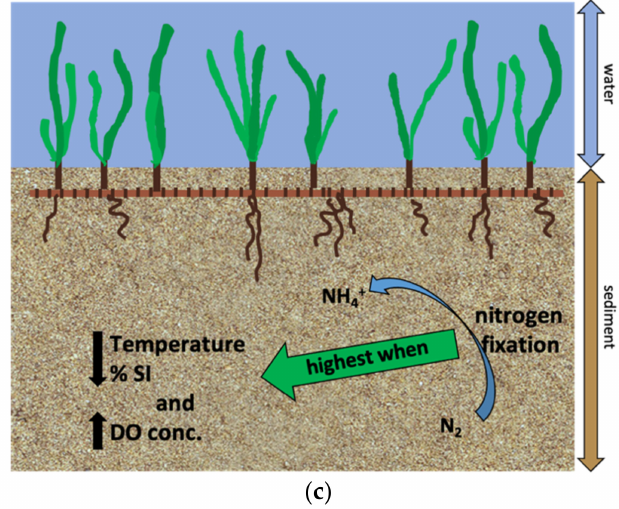
Figure 8. Conceptual models for conditions that stimulated sediment nitrogen fixation in the different substrate types: ( a ) Organic matter remineralization in unvegetated sediments resulted in increased inorganic nutrients and carbon energy sources for diazotrophic sulfate reducing bacteria which produced sulfide; ( b ) Decreased availability of bioavailable nitrogen relative to phosphorus stimulated nitrogen fixation in sediments colonized by H. wrightii ; ( c ) In sediments colonized by T. testudinum , nitrogen fixation was highest when water column temperature and percent surface irradiance were at their lowest and water column dissolved oxygen was at its highest. These conditions were associated with dormancy which had the highest percent organic matter content in the